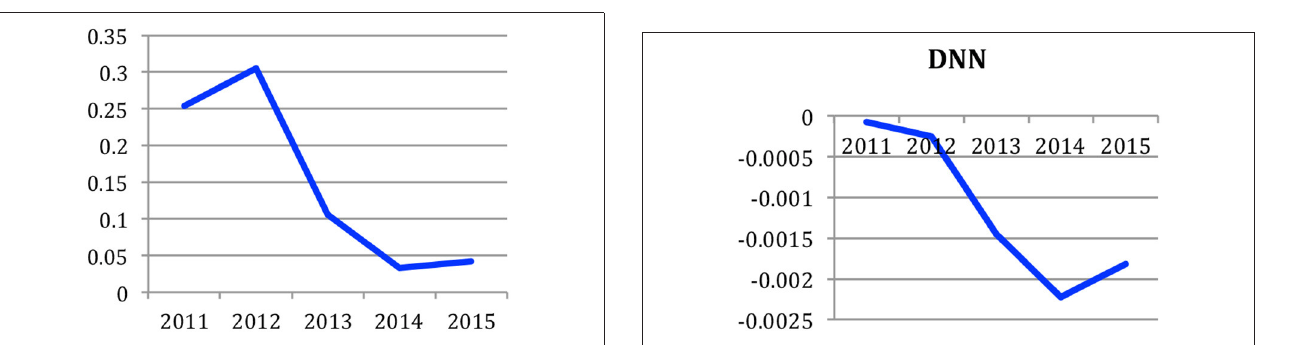
FIGURE 9 | Evolution of the distance between prediction and observation over the years.